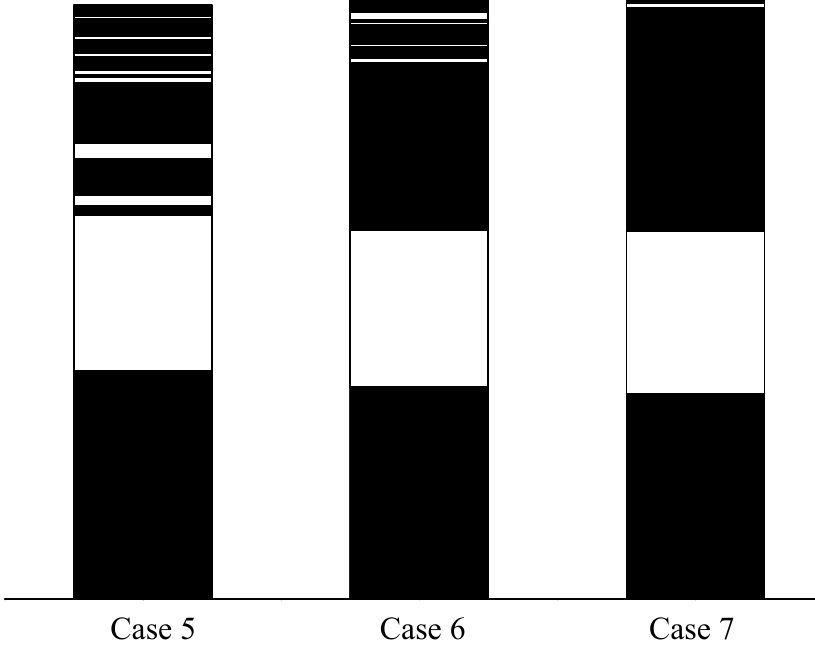
Figure 13. Distribution of ice lenses at different thermal conductivity of solid particles.